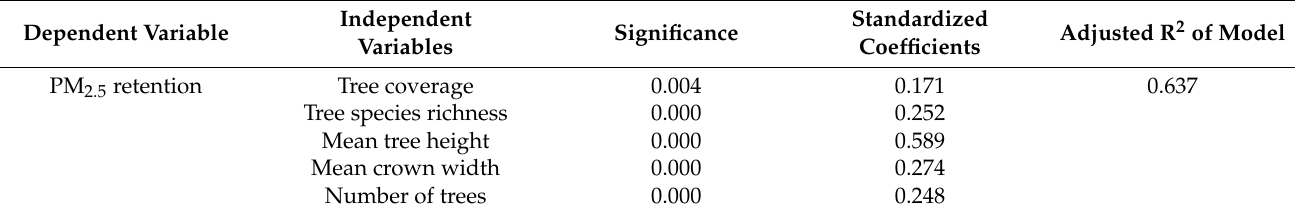
Table 2. Stepwise regression analysis of green space structural parameters and PM 2.5 retention.